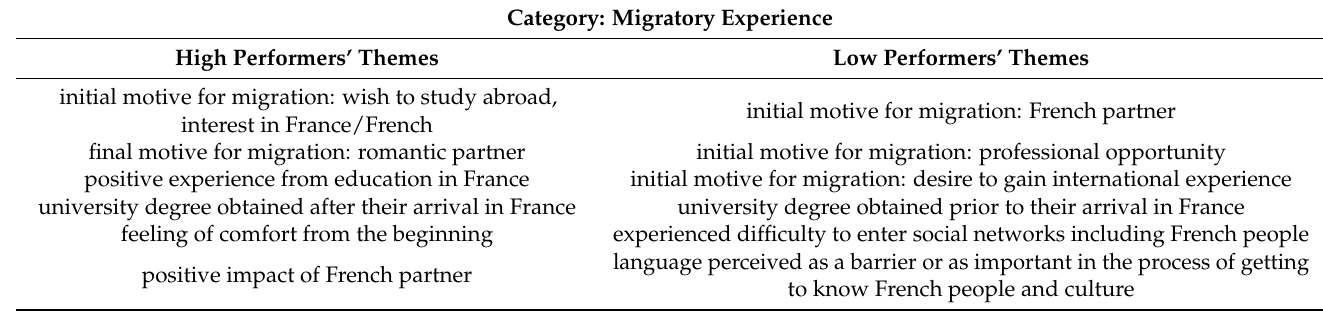
Table 2. Identified themes in the category “Migratory